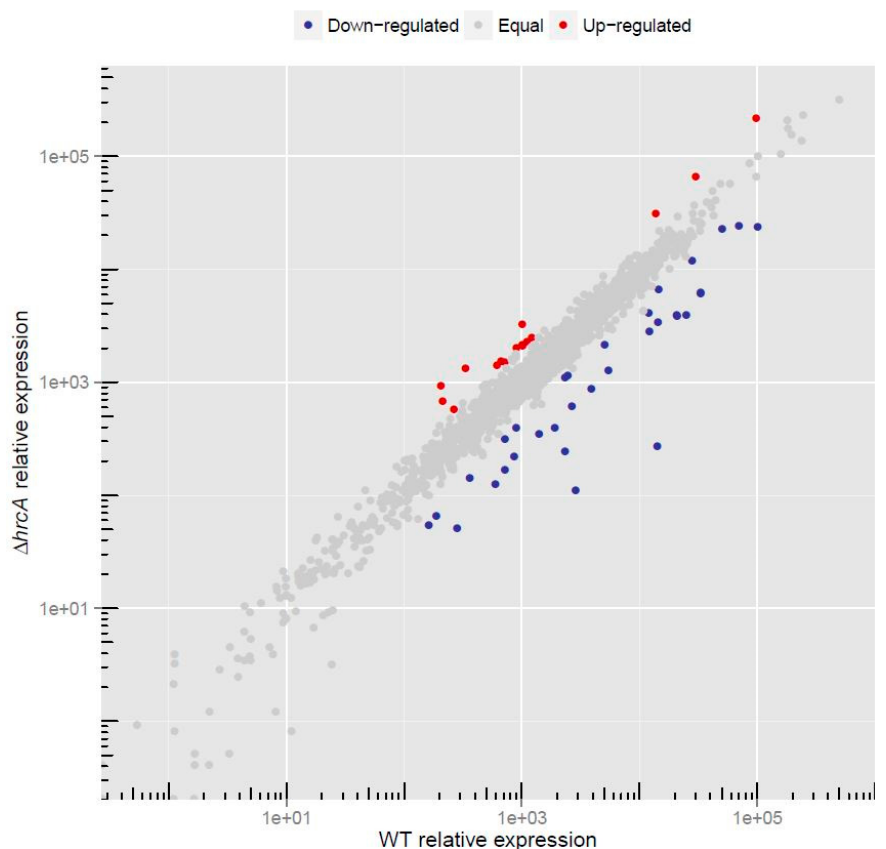
Figure 1. Genome-wide HrcA-dependent gene expression. The plot shows log10 scale means of the normalized counts obtained from H. pylori G27 wild type (x axis) and from the isogenic ∆ hrcA deletion mutant (y axis) duplicates for each of the expressed genes. Genes found to be up-regulated, down-regulated or unchanged comparing ∆ hrcA and wild type in DESeq2 analysis are represented as red, blue and grey dots, respectively.